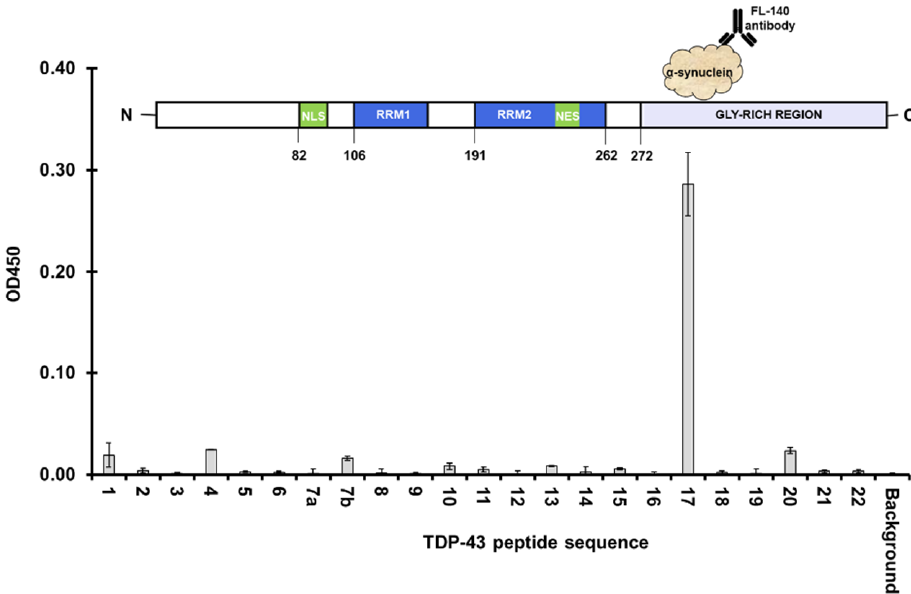
Figure 7. Probing epitope interactions of TDP-43 with other recombinant proteins using a microplate-based approach. Peptide 17 (aa 310–329) of TDP-43 showed a significant amount of bound full length α -synuclein.